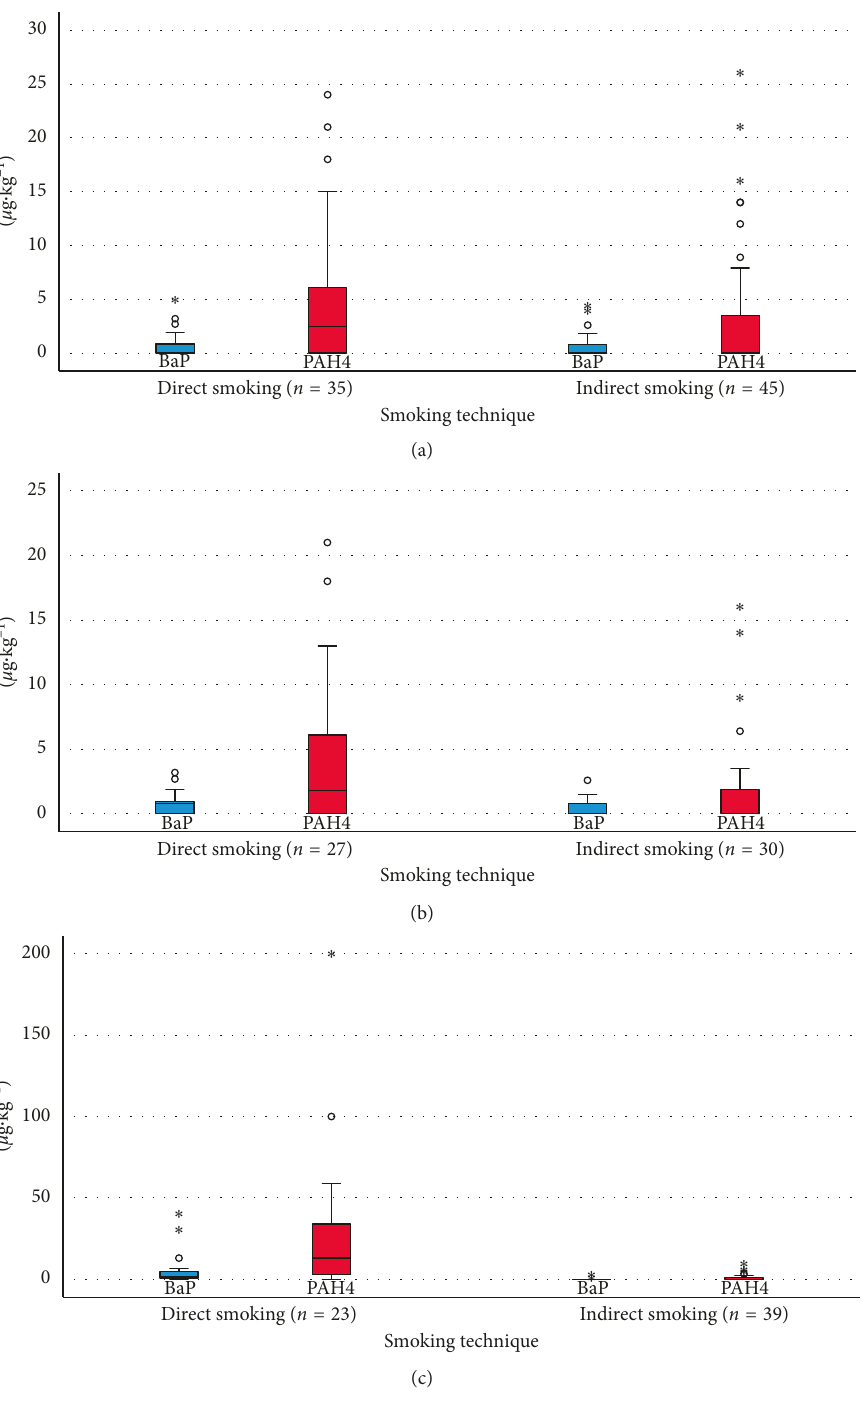
Figure 3: (a) Boxplot diagrams of BaP and PAH4 concentrations in µ g · kg − 1 wet weight for fish products divided according to the smoking technique used. The line in the central box represents the median, the whiskers show the distribution outside the central quartiles, and the circles and stars are outliers. N is the number of samples. (b) Boxplot diagrams of BaP and PAH4 concentrations in µ g · kg − 1 wet weight for salmon fillet products divided according to the smoking technique used. The line in the central box represents the median, the whiskers show the distribution outside the central quartiles, and the circles and stars are outliers. N is the number of samples. (c) Boxplot diagrams of BaP and PAH4 concentrations in µ g · kg − 1 wet weight for meat products divided according to the smoking technique used. The line in the central box represents the median, the whiskers show the distribution outside the central quartiles, and the circles and stars are outliers. N is the number of